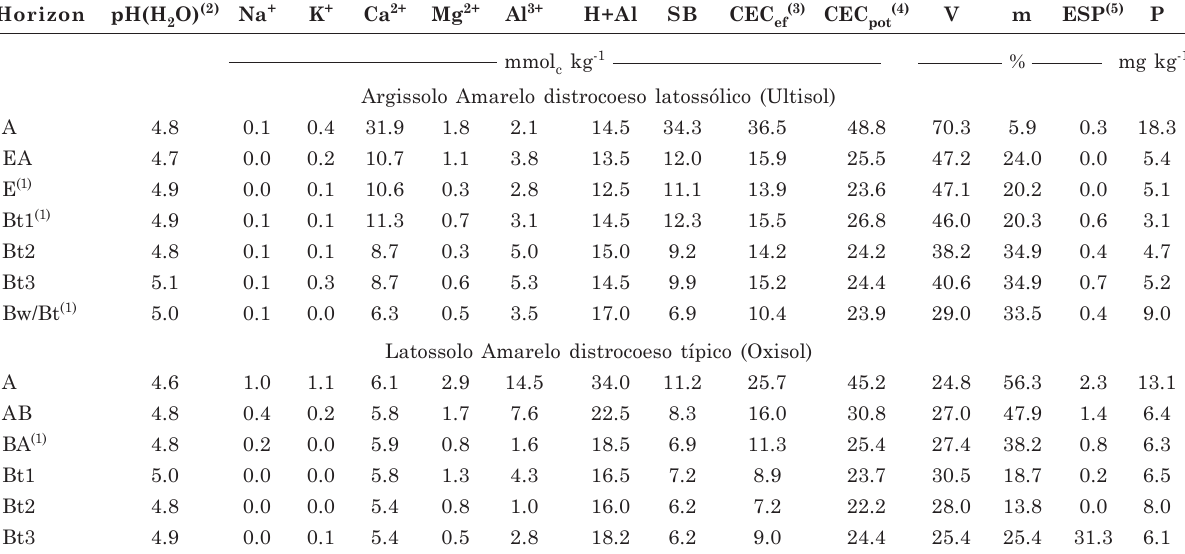
Table 2. Chemical properties of the evaluated soil